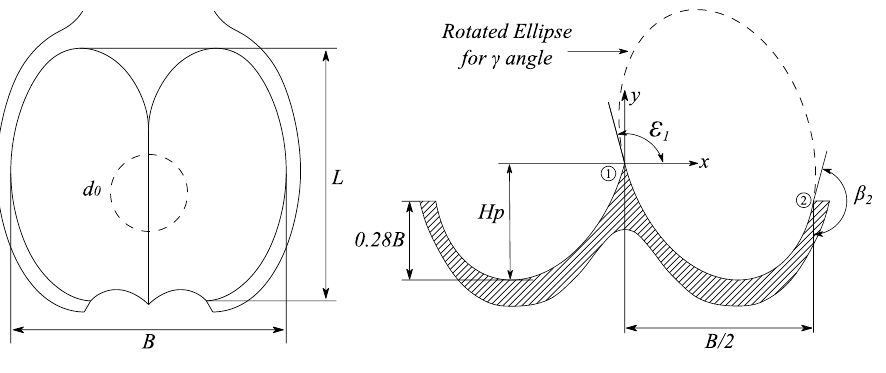
Figure 10. Main Dimensions of Pelton Buckets .